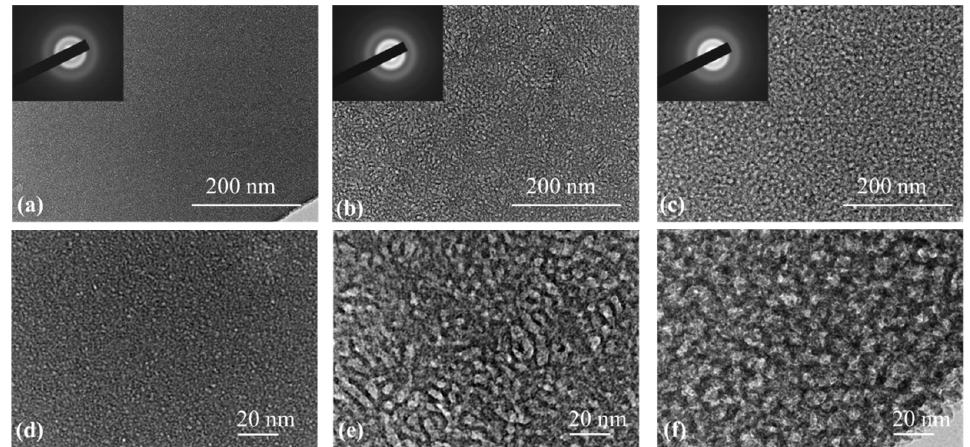
Figure 1. TEM images and corresponding SAED patterns (as insets) of dense Nb 2 O 5 thin films ( a , d ) and Nb 2 O 5 films templated with aqueous solutions of Pluronic PE 6200 ( b , e ) and Pluronic PE 6800 ( c , f ) with concentration of 20% w / v .